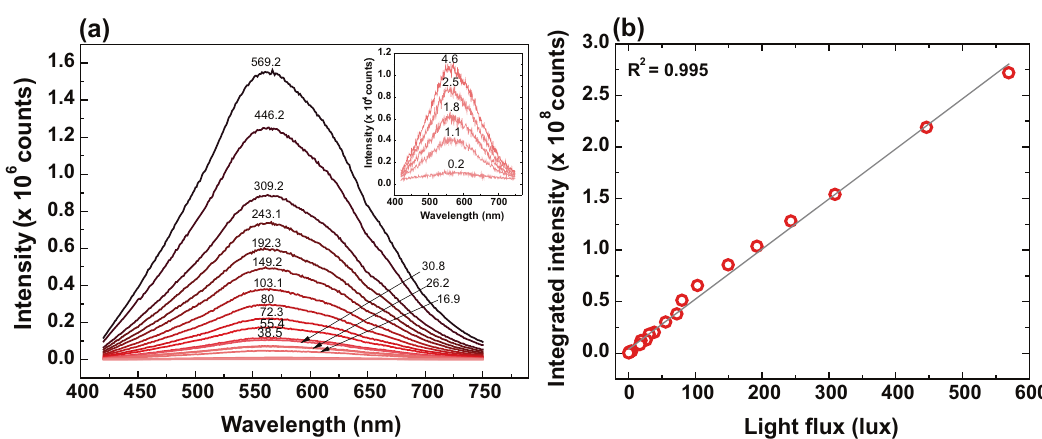
Fig. 4 Power-dependent photoluminescence properties. a Power-dependent photoluminescence spectra of Bi 0.10 In 0.90 compound. The photon fl ux (380 nm) is varied from 0.2 lux to 569.2 lux. The inset shows the photoluminescence at low photon fl uxes (0.2 – 4.6 lux). b The integrated intensity under the photoluminescence curve shown in Fig. 4a is plotted as a function of incident photon